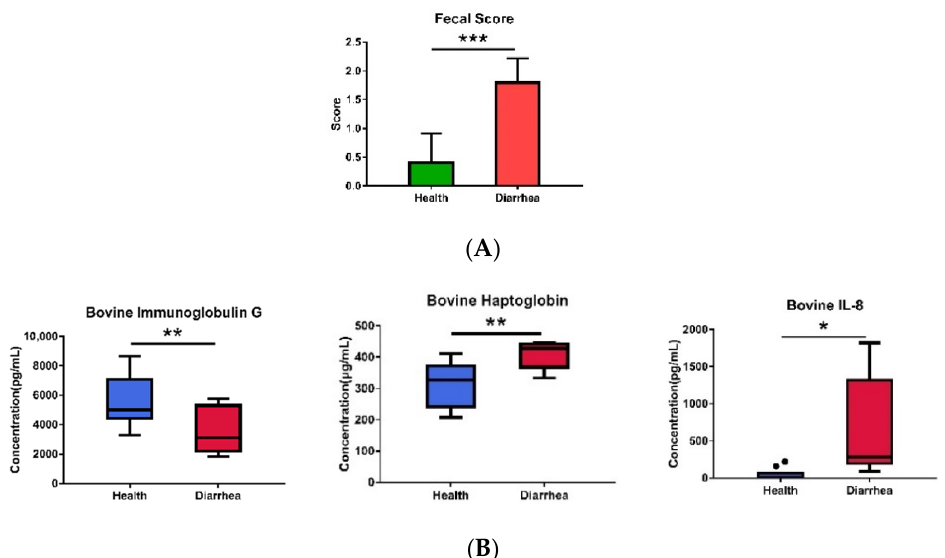
Figure 1. Evaluation of ( A ) the fecal score and ( B ) serum IgG, HP, and IL-8 in calves. The values are presented as the mean ± SD ( n = 10) between groups. Data were analyzed by unpaired Student’s t -test. Significant difference: * p < 0.05, ** p < 0.01, *** p < 0.001. The dot represent the outlier value of samples.